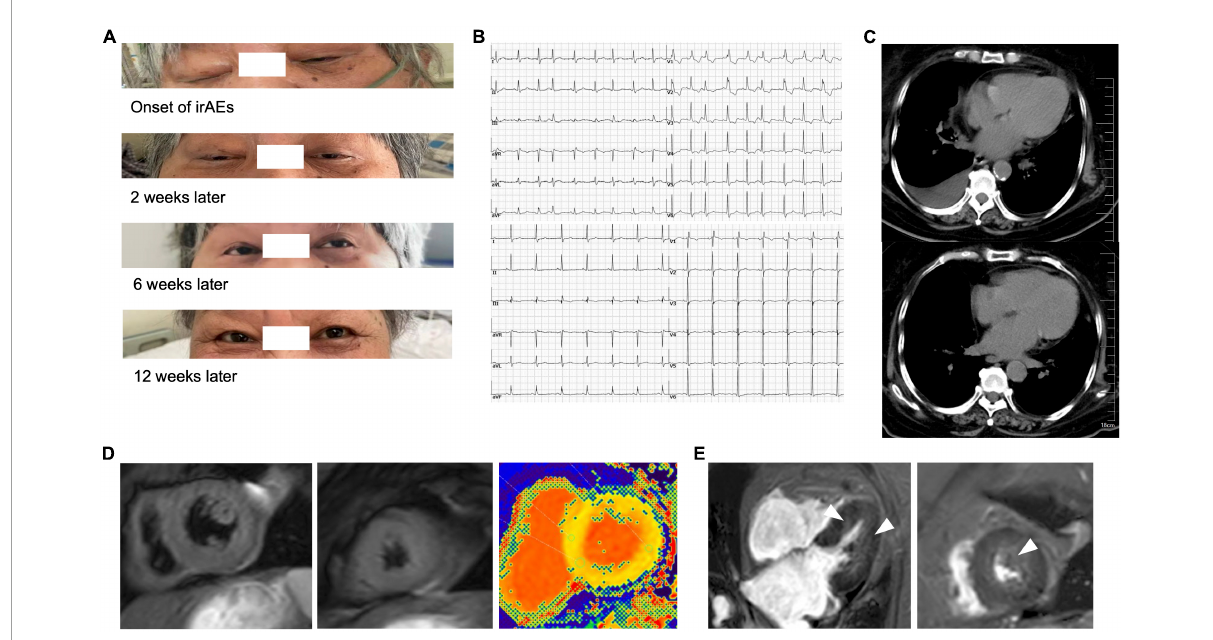
FIGURE1 Eyelid ptosis and radiographical presentations of immune-related myocarditis. (A) Both eyelid ptosis occurred at the time of immune-related adverse events (irAEs) onset and improved gradually after the steroid treatment and intravenous immunoglobulin (IVIG). (B) The electrocardiogram showed ectopic heart rhythm and atrial arrhythmia before (upper) and after (lower) the steroid treatment. (C) Temporary right pleural infusion before (upper) and after (lower) the steroid treatment by CT scan. (D) In the third month after the onset of irAEs, the patient received a supplementary cardiac magnetic resonance (MR) examination revealing no edema and hyperemia (left and central), and quantitative myocardial T1 mapping was normal (right). (E) Delayed myocardial enhancement showed patchy enhancement that may be old myocardial injuries resulting from immune-related cardiac toxicity (arrow).